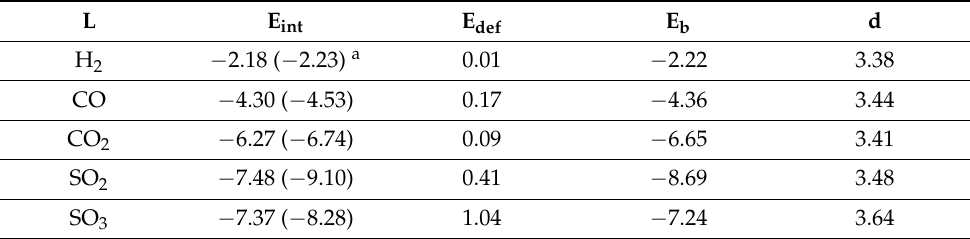
Table 5. Interaction, binding, and deformation energies (kcal/mol) of C 18 ··· L ··· C 18 inclusion com- plexes calculated at the ω B97XD/Def2TZVPP level of theory. In addition, also listed as d (Å) is the distance between ring planes.